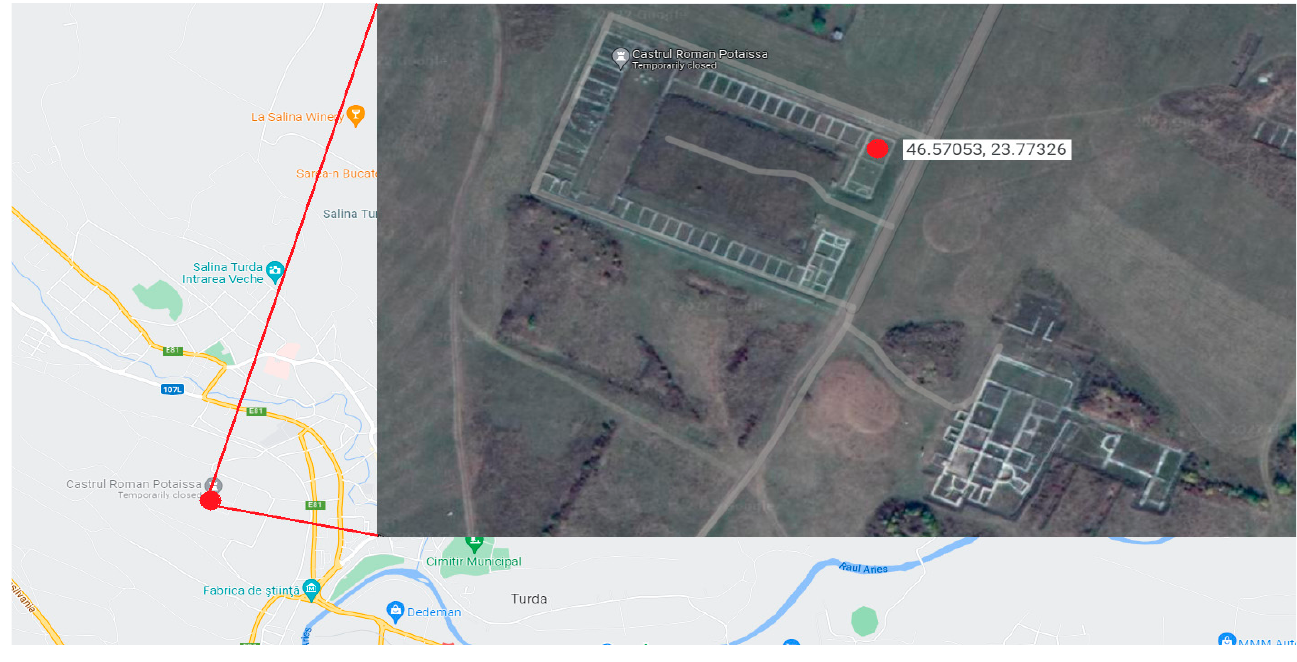
Figure 1. Geographical placement of the Potaissa Roman Fortress, Turda, Romania, [Google Maps view 2022] GPS coordinates: 46.57053, 23.77326.